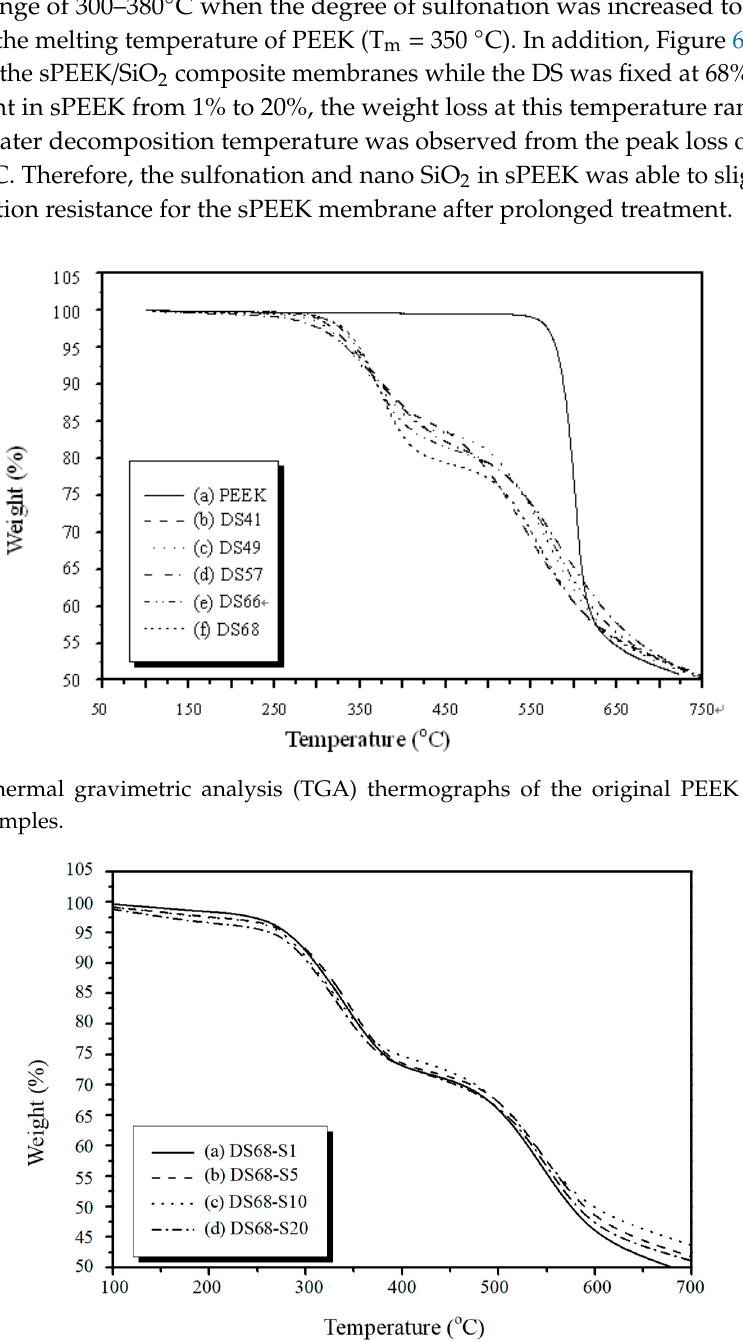
Figure 6. TGA thermographs of the sPEEK / SiO 2 composite membranes with a 68% degree of sulfonation (DS68). The nano SiO 2 content varied at 1% (S1), 5% (S5), 10% (S10), and 20% (S20).